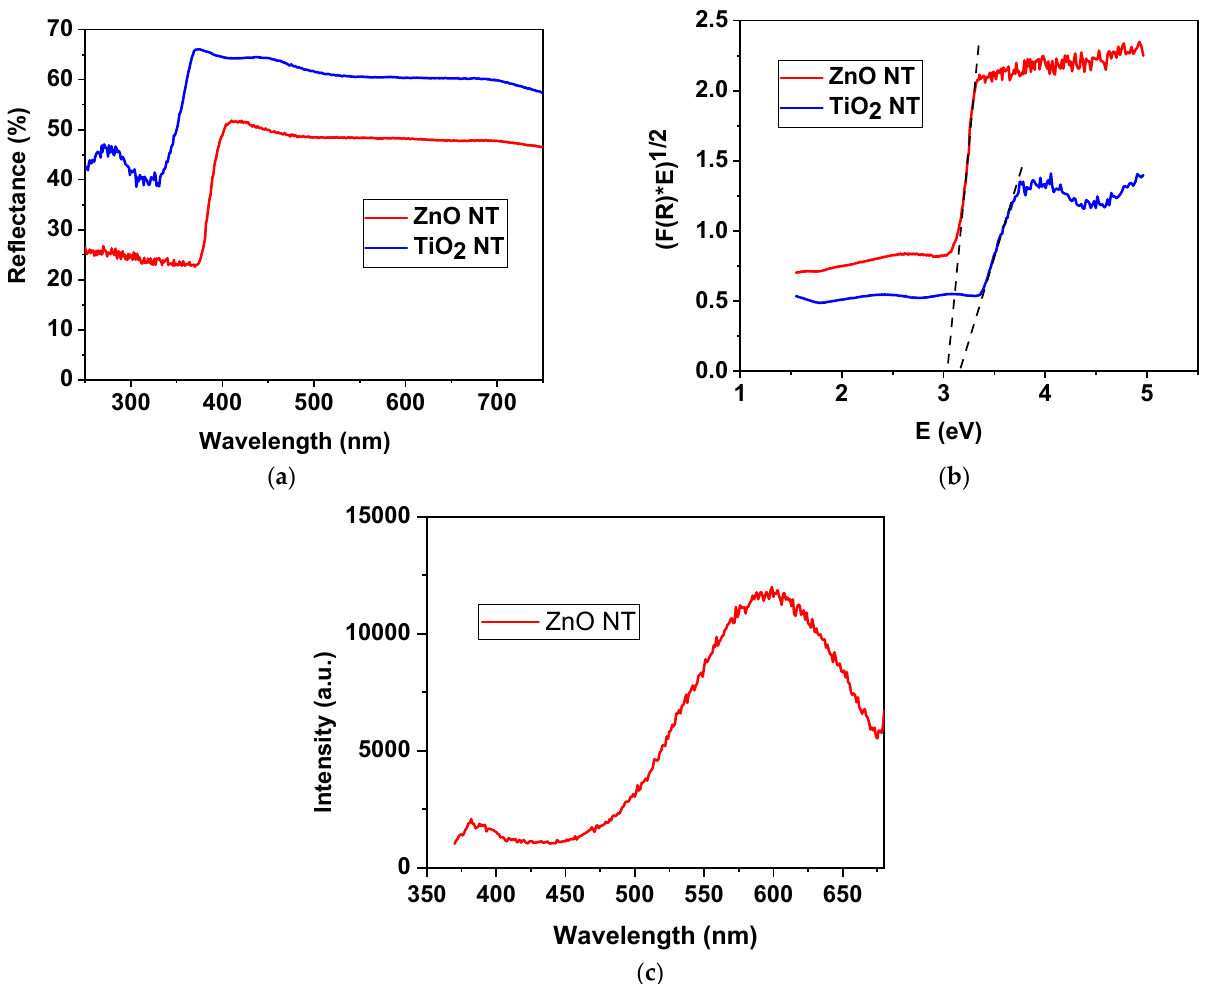
Figure 5. (a) Reflectance spectra of ZnO and TiO 2 nanotubes; (b) Tauc’s plots of transformed Kubelka–Munk functions Figure 5. ( a ) Reflectance spectra of ZnO and TiO 2 nanotubes; ( b ) Tauc’s plots of transformed Kubelka–Munk functions used used to estimate the band gap energies of the samples; (c) photoluminescence spectrum of ZnO nanotubes excited with to estimate the band gap energies of the samples; ( c ) photoluminescence spectrum of ZnO nanotubes excited with 350 nm 350 nm wavelength.